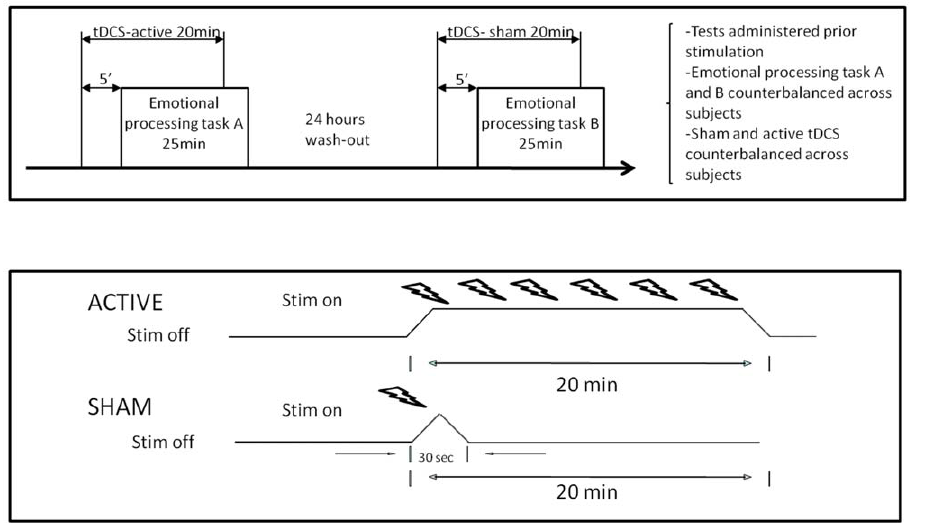
Figure 1. Experimental design. Each subject underwent sham and active stimulation on two different days in a counterbalanced design (see panel A). Two equivalent emotional processing tasks were used (A and B in the figure), which were randomized within subjects. For real tDCS, 20 min of 1mA was continuously applied whereas for the sham stimulation the current stimulator was turned only during the first 30 seconds, to mimic the somatic sensations without actually affecting the underlying cerebral cortex (see panel B).